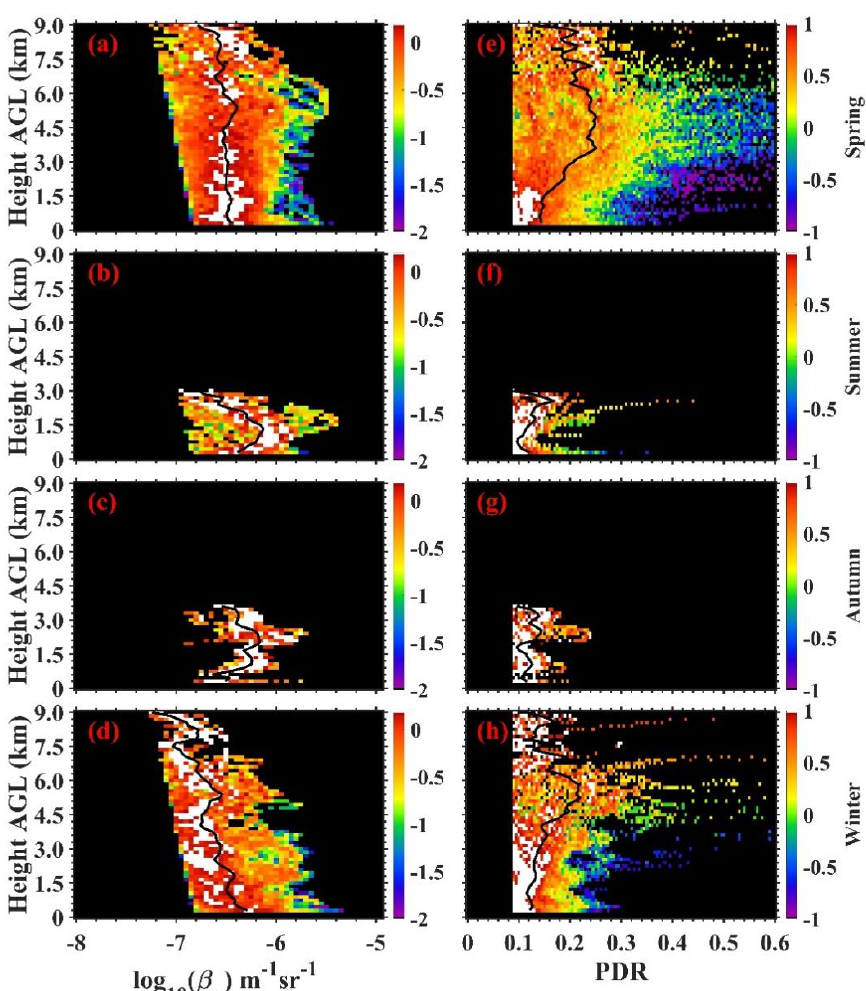
Figure 5. The vertical PDF distribution of seasonal particulate backscatter coefficients ( a – d ) and PDR for MPL ( e – h ) at the NSA site from January 2013 to September 2017. Rows from top to bottom are for spring ( a , e ), summer ( b , f ), autumn ( c , g ) and winter ( d , h ), separately. The seasonal average profiles (black lines) are plotted in each sub-figure. The color bar is the log scale of PDF distribution values of particular backscatter coefficients and PDR in each 150 m.